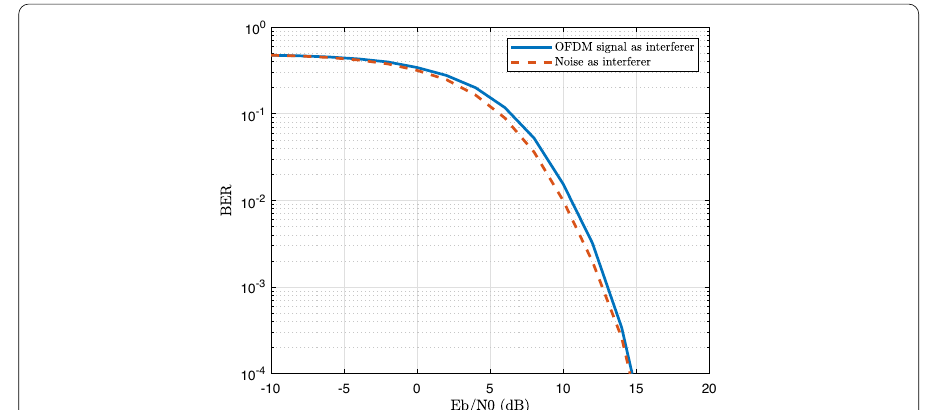
Fig. 7 BLE receiver immunity against OFDM modulated and AWGN